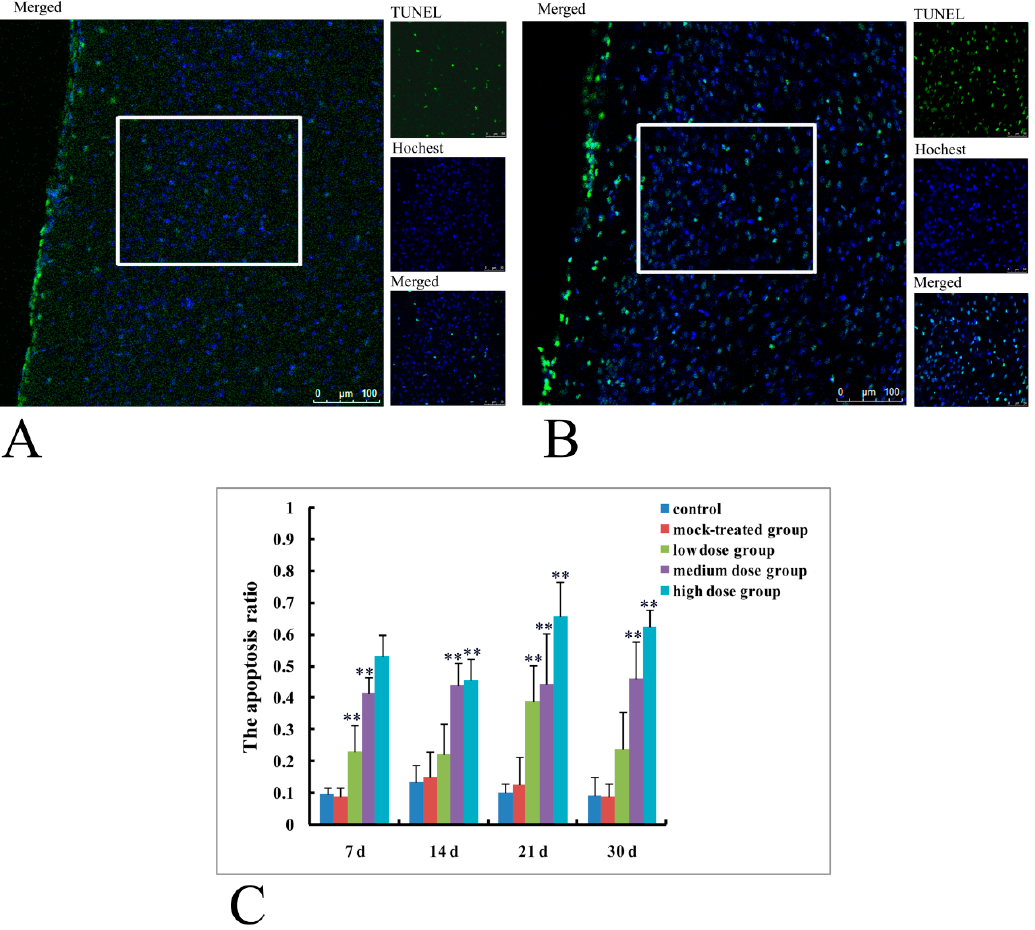
Figure 3. Apoptosis of cerebral cortex neurons in mice offspring after maternal exposure to PM 2.5 during pregnancy. ( A ) TUNEL of mice offspring on postnatal day 14 from mock-treated group; TUNEL, Hochest and merged figures were derived from the area marked by the white box; ( B ) TUNEL of mice offspring on postnatal day 14 from high-dosage group; TUNEL, Hochest and merged figures were derived from the area marked by the white box; ( C ) the apoptotic ratio of nerve cells. Bar = 20 µm. ** p < 0.01, compared with control.